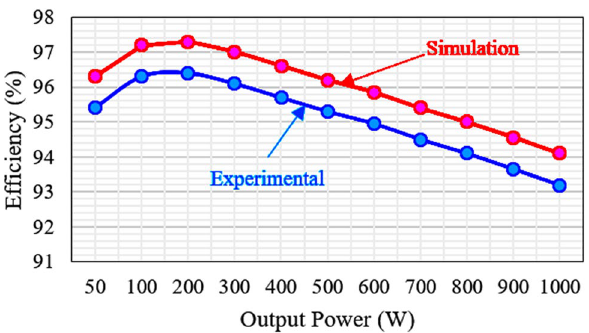
Figure 7. Output power vs efficiency of proposed RSC-SB2 topology.